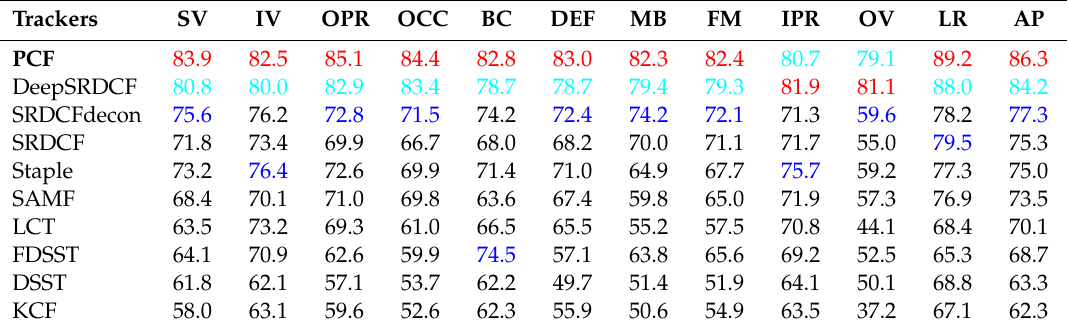
Table 7. SP of the OPE on OTB-2015 benchmark for the top ten trackers on eleven different attributes (%): SV, IV, OPR, OCC, BC, DEF, MB, FM, IPR, OV, LR. The last column is the average precision of LET at 20 pixels. The last column is the AUC of the OPE. The top three ranks are expressed in red , cyan , and blue respectively.